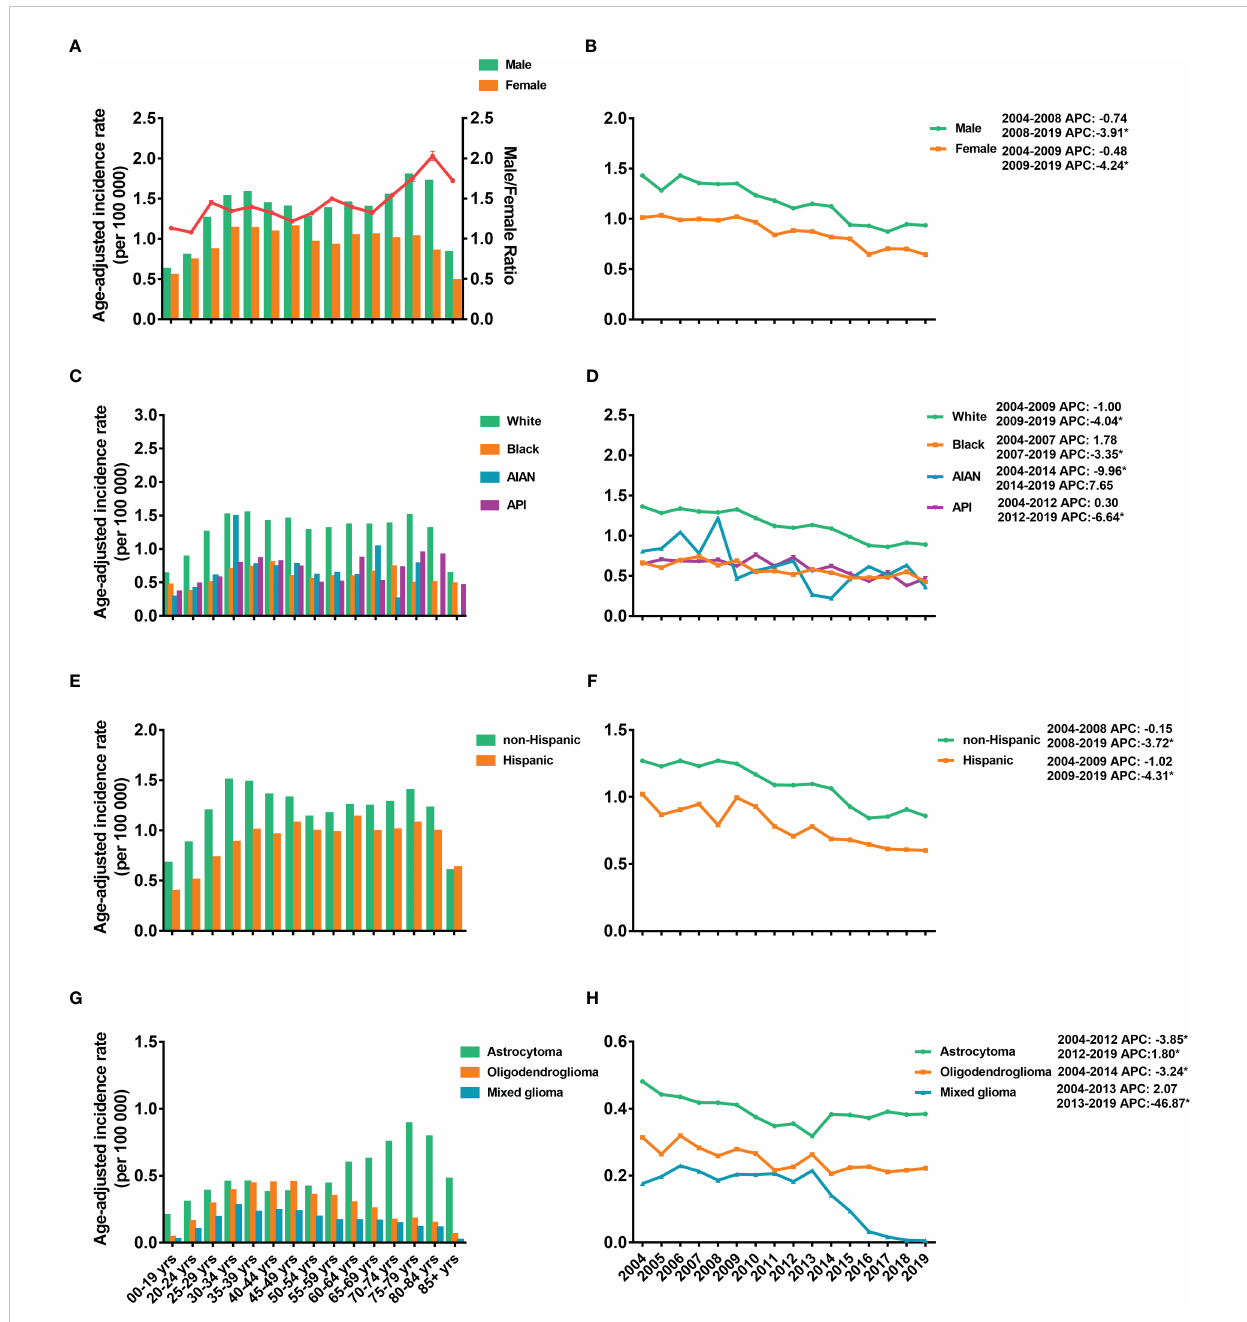
FIGURE 1 Age-adjusted incidence rates (IRs) and annual percent changes (APCs). IRs by 5-year age intervals and by sex (A) , race (C) , ethnicity (E) , and histological subtypes (G) . APCs by sex (B) , race (D) , ethnicity (F) and histological subtypes (H) over time from 2004 – 2019. * P <